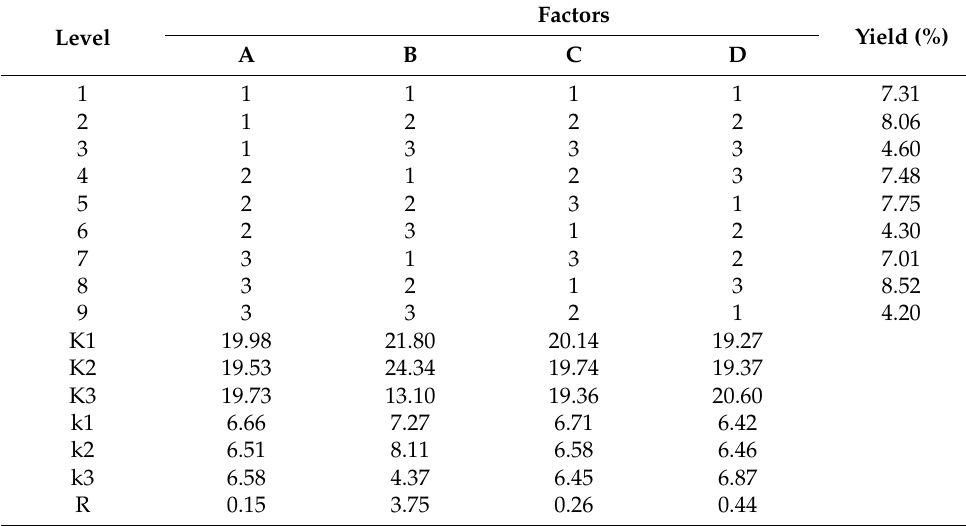
Table 2. The results of orthogonal experimental design.